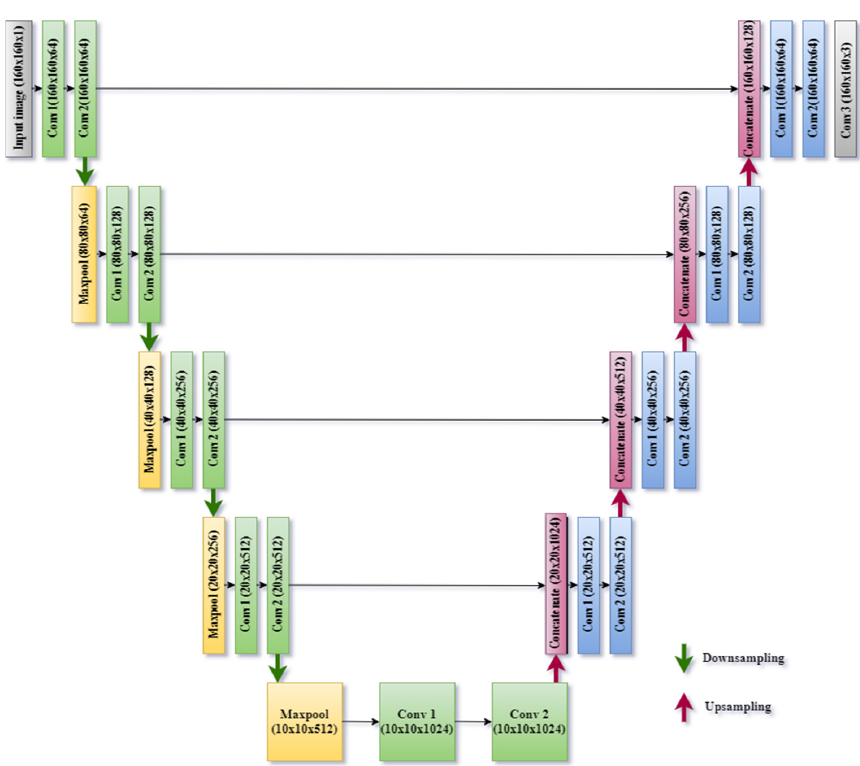
Figure 7. U ‐ Net Model from Scratch. Figure 7. U-Net Model from